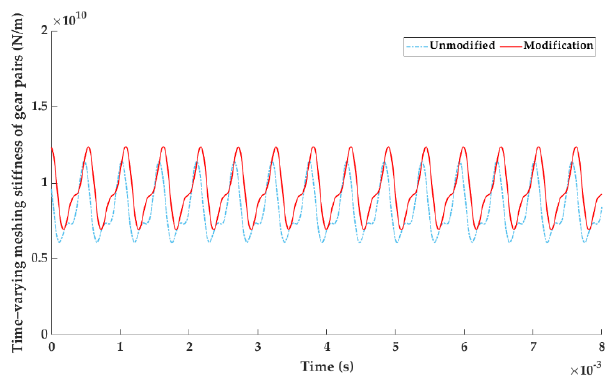
Figure 17. TVMS curve at a load of 100 N·m.